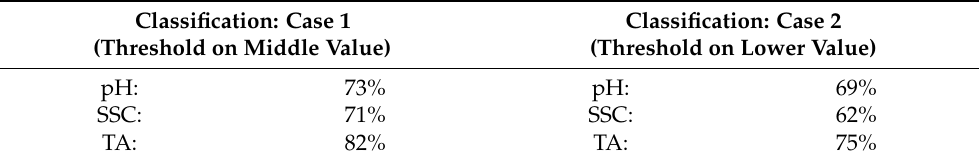
Table 5. Interpretation of regression results of classification accuracies in two classes, based on selected thresholds, for all three chemical